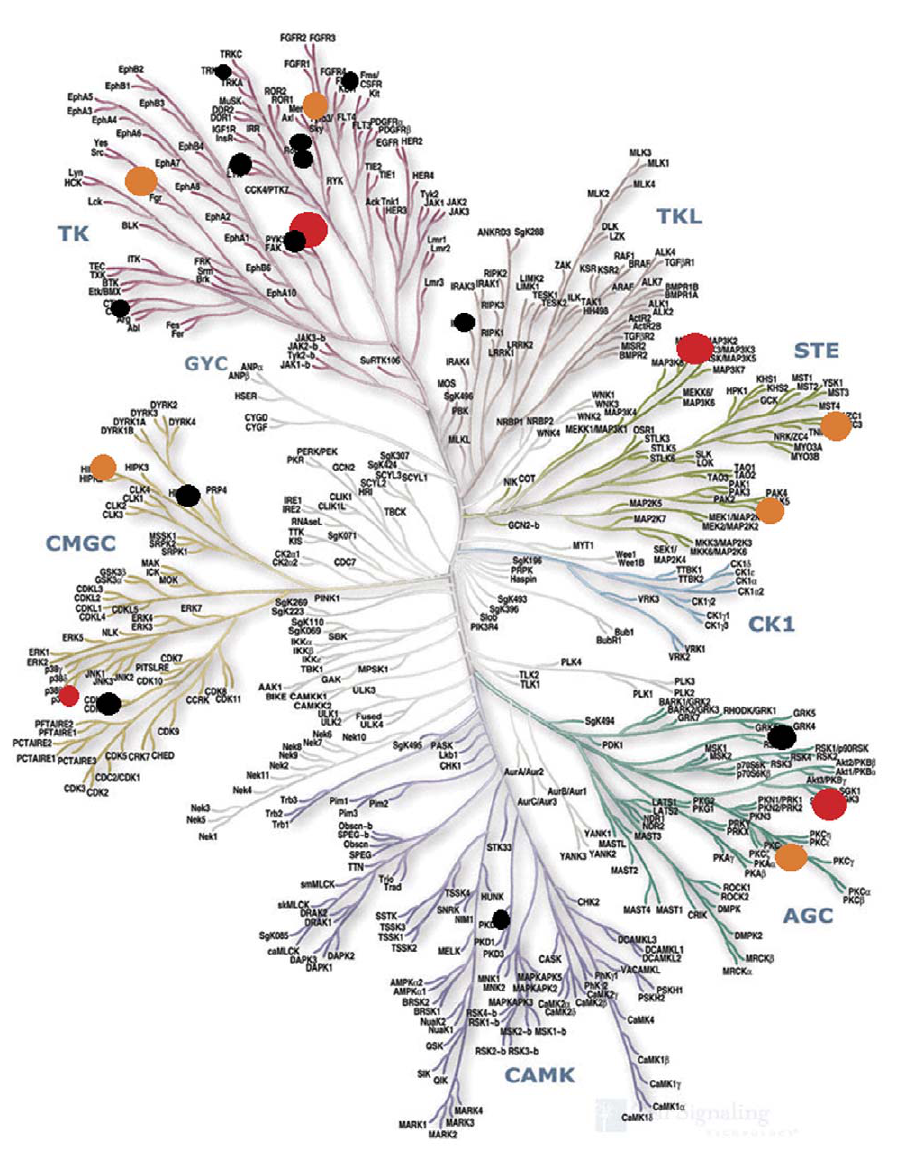
Figure 16. Kinome map of the compound 12a inhibition % is scaled using color coding as follow: 20%–40% black circles, 40%–70% orange circles and . 70% in red circles. The radius of the circle corresponds to the inhibition % within this range.